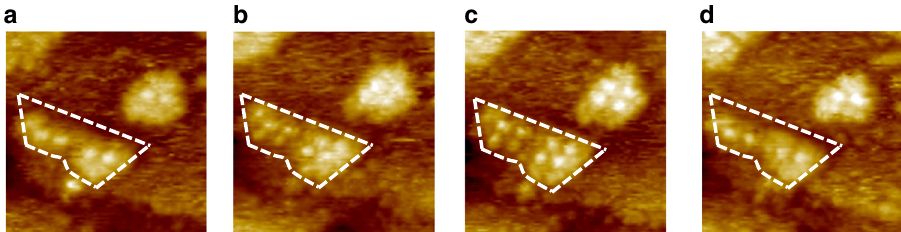
generalized gradient approximation (GGA). The gradient-corrected Perdew Burke Enzerhof (PBE) exchange-correlation functional is employed together with an energy cutoff of 400 eV and Gamma k-points. The van de Waals interactions are described by a semi-empirical Grimme DFT-D2 approach 53 – 56 . The ionic core is represented by ultrasoft pseudopotentials. All the results are based on non-spin polarization calculations with density mixing scheme. First, the performance of different methods and parameters were tested on calculating the bulk fcc lattice constant of Au (see Supplementary Tables 6 and 7), whereby we chose the C6 coef fi cient and the R0 van der Waals radius of 422eV Å6 and 1.772Å for Au, respectively. Lattice parameters a and b were determined by above calculations as 2.910 Å, corresponding to a bulk fcc lattice constant of 4.115 Å. The surface-supported island structure is described by a 7× 9 supercell consisting of four monolayers of (111)-oriented Au slab, a 7 ×6 adatom layer and a vacuum layer of 20Å. The bottom three Au layers are frozen in calculations while the surface layer, the Au island and the helicene are fully relaxed until the convergence criteria reach 2× 10 − 6 eV for SCF, 2× 10 − 5 eV/atom for electronic